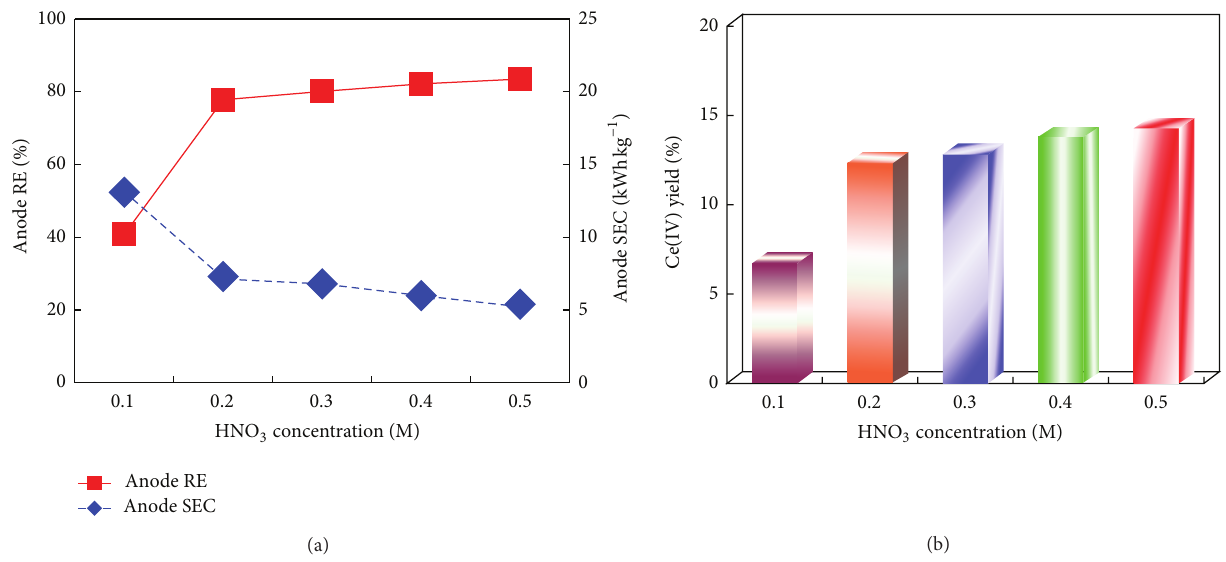
Figure4:EffectofHNO 3 concentration:(a)removalefficiencyandSECofPVAand(b)Ce(IV)yieldwithdifferentHNO 3 concentrationinthe anodic compartment (current density = 3mAcm −2 , temperature = 323 K, anodic compartment: PVA = 50 mg L −1 , Ce(III) = 0.01M; cathodic compartment: PVA = 50 mg L −1 , Na 2 SO 4 = 0.05 M, pH = 3, oxygen flow rate = 500 cm 3 min −1 , and UV-light intensity = 0.4 mWcm −2 ).